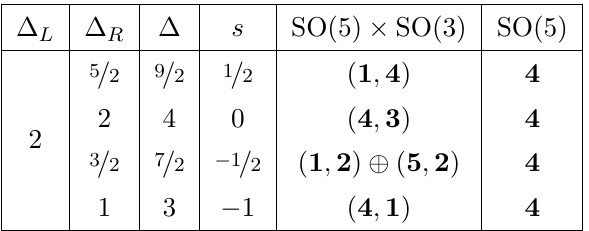
Table 11. Mass spectrum for the OSp(4 (cid:3) j 4) solution for diagonal embedding (2.21a) with gauge group Sp(2 ; 2) (cid:2)